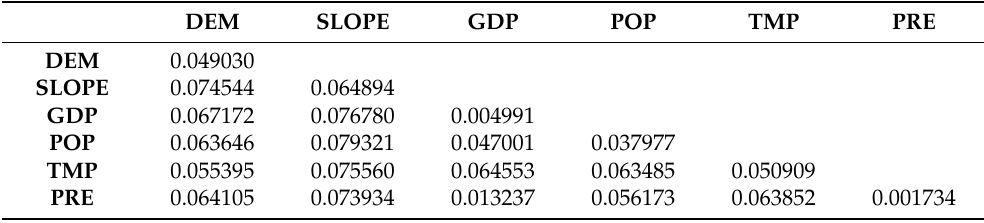
Table A11. The force (q-value) among any two influencing factors on Largest Patch Index (LPI) interactively in